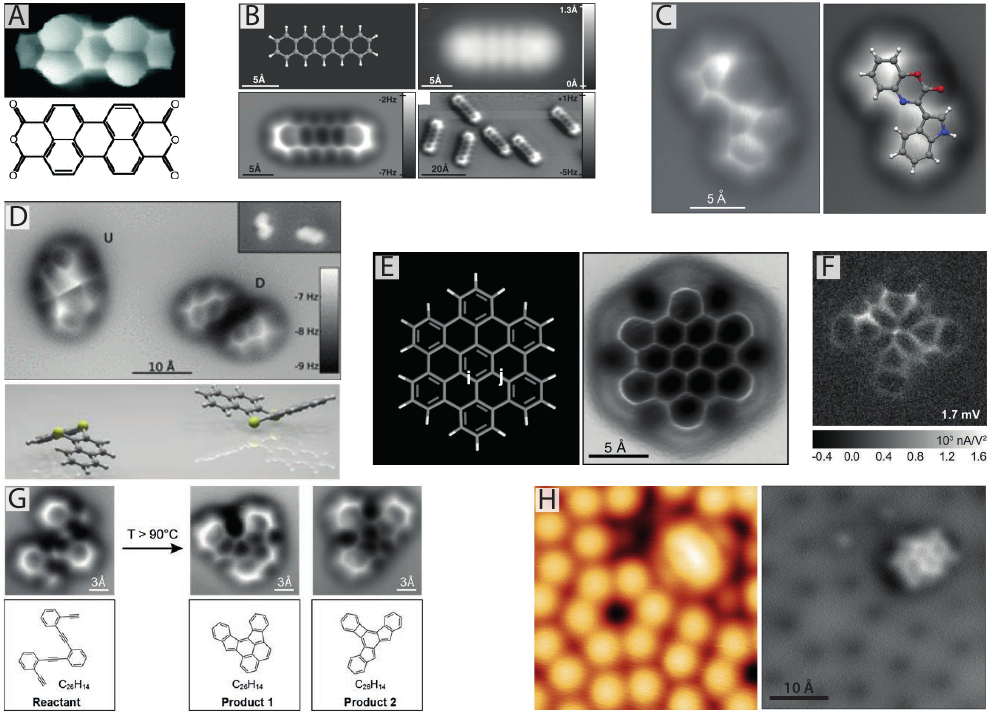
Figure 1. Imaging internal bond structure with CO-mediated non-contact atomic force microscopy (NC-AFM). ( A ) Internal bond structure of perylene-tetracarboxylic-dianhydride (PTCDA) resolved with scanning tunnelling hydrogen microscopy (STHM) using a trapped hydrogen molecule in the scanning tunnelling microscope (STM) tunnel junction [14,16]; ( B ) First images of internal bond structure resolved with NC-AFM achieved via pick-up of a single CO molecule onto the tip apex (from [24], reprinted with permission from AAAS); ( C ) NC-AFM images showing molecular structure identification of cephalandole A adsorbed on NaCl (2 ML)/Cu(111). Red and blue coloured atoms correspond to oxygen and nitrogen, respectively (reprinted by permission from Macmillan Publishers Ltd.: Nature Chemistry [27], copyright 2010); ( D ) NC-AFM reveals bistable configurations of dibenzo[a,h]thianthrene (DBTH) adopting a “butterfly” arrangement. Yellow coloured atoms correspond to sulphur (reprinted with permission from [28], copyright 2012 by the American Physical Society); ( E ) Pauling bond order discrimination in hexabenzocoronene with NC-AFM (from [29], reprinted with permission from AAAS); ( F ) Inelastic tunnelling spectroscopy (IETS) image revealing chemical bonds with a CO-terminated tip (from [30], reprinted with permission from AAAS); ( G ) NC-AFM images of the different steps of a chemical reaction with submolecular resolution (from [31], reprinted with permission from AAAS); ( H ) STM (left) and NC-AFM (right) imaging of the structure and adsorption site of naphthalene tetracarboxylic diimide (NTCDI) on the Si(111)- 7 × 7 surface at 77 K